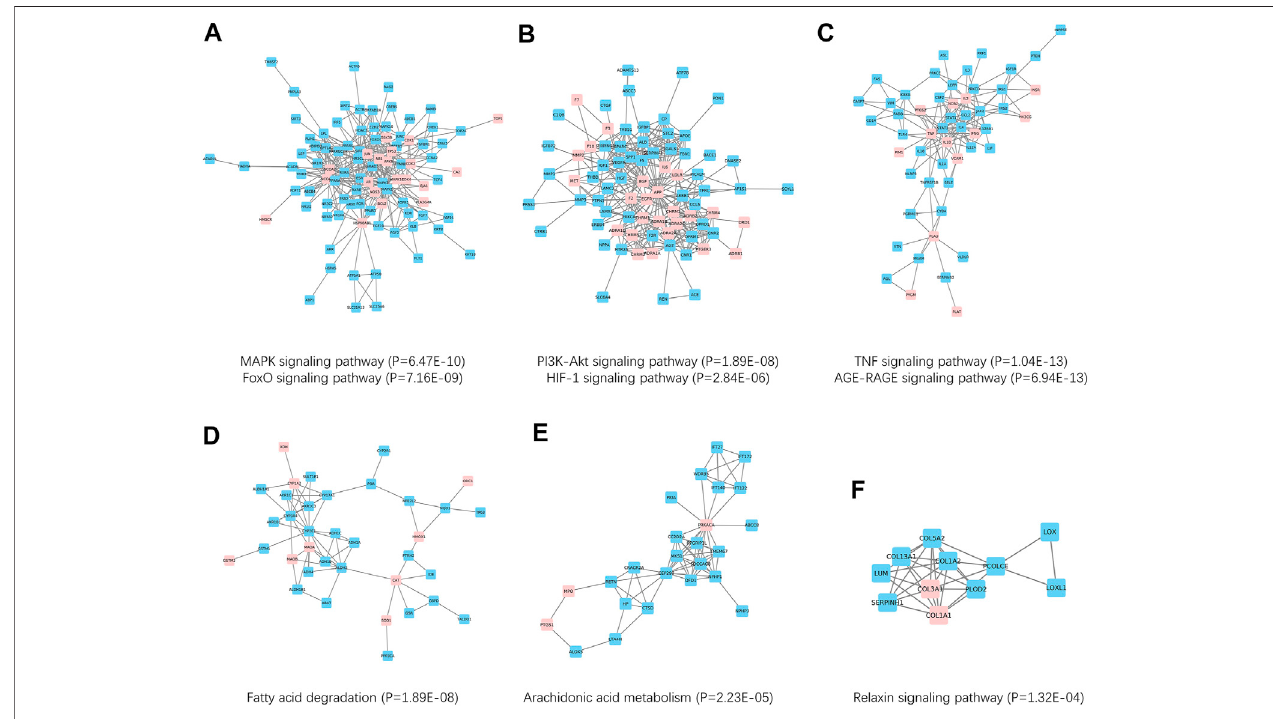
FIGURE 5 | Network-based clusters identi fi cation and Kyoto Encyclopedia of Genes and Genomes (KEGG) enrichment. (A) Cluster 1 was related to MAPK and FoxO pathways. (B) Cluster2wasrelated toPI3K-Akt andHIF-1pathways. (C) Cluster3wasrelated toTNFand AGE-RAGE pathways. (D) Cluster4wasrelated tothe fatty acid degradation pathway. (E) Cluster 5 was related to the arachidonic acid metabolism pathway. (F) Cluster 6 was related to the relaxin pathway.